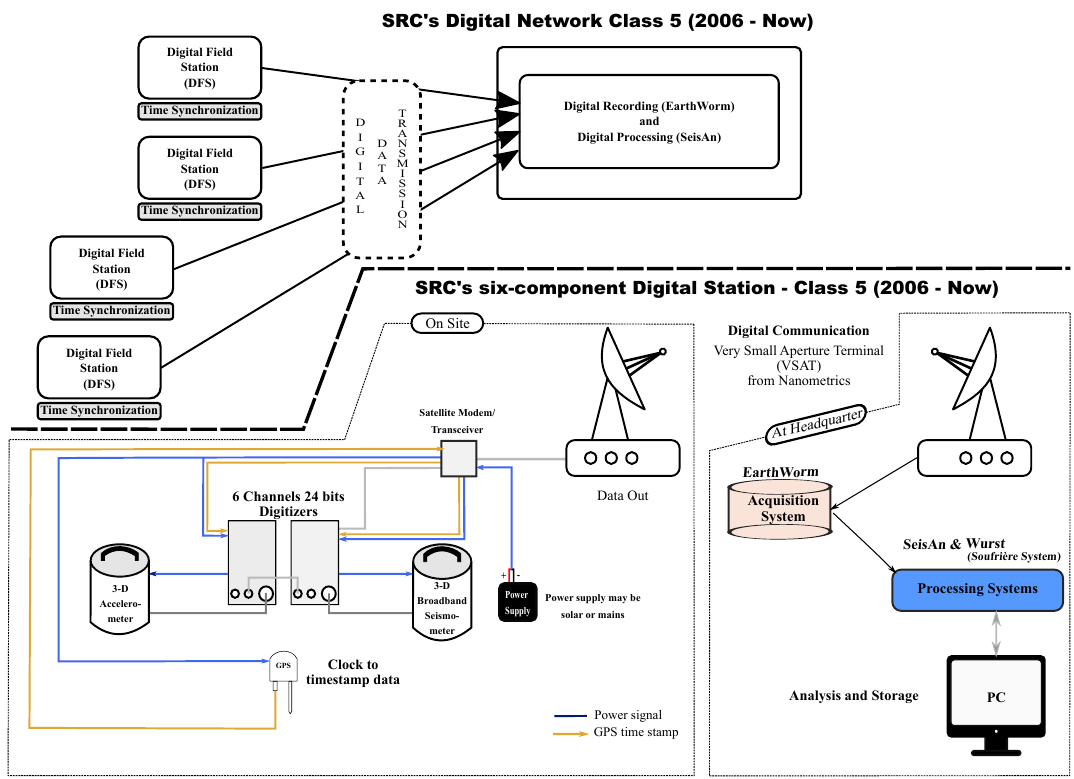
Figure 11. SRC digital network design from field station to hub (SRC headquarter in St Augustine, Trinidad).